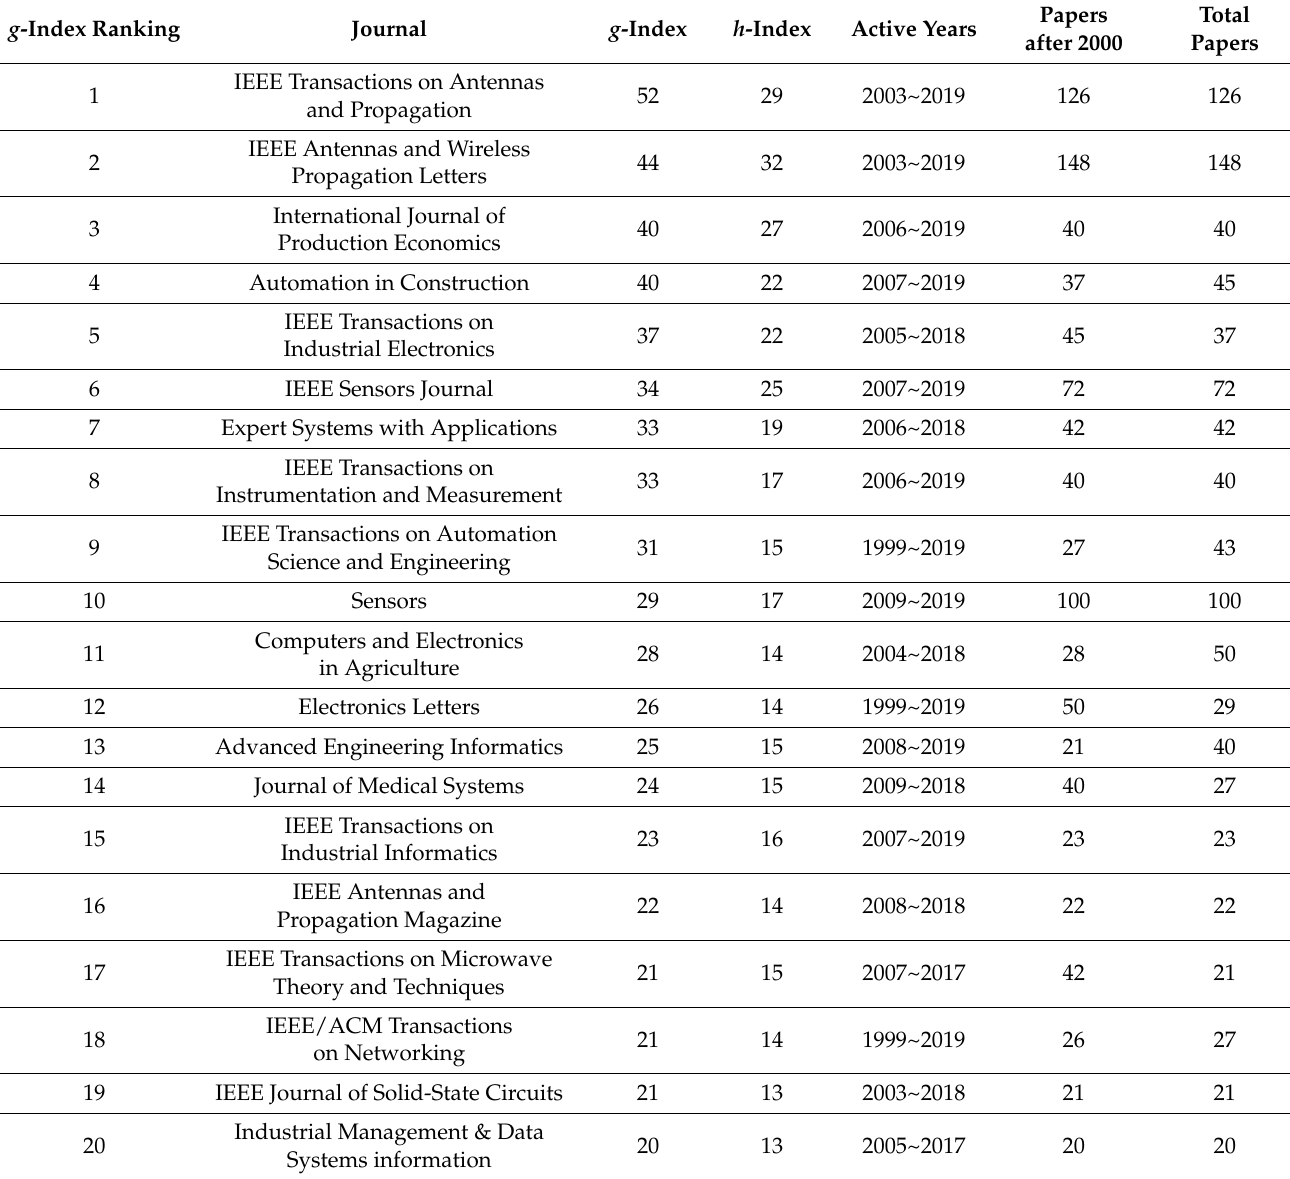
Table 1. Top 20 most influential journal in RFID